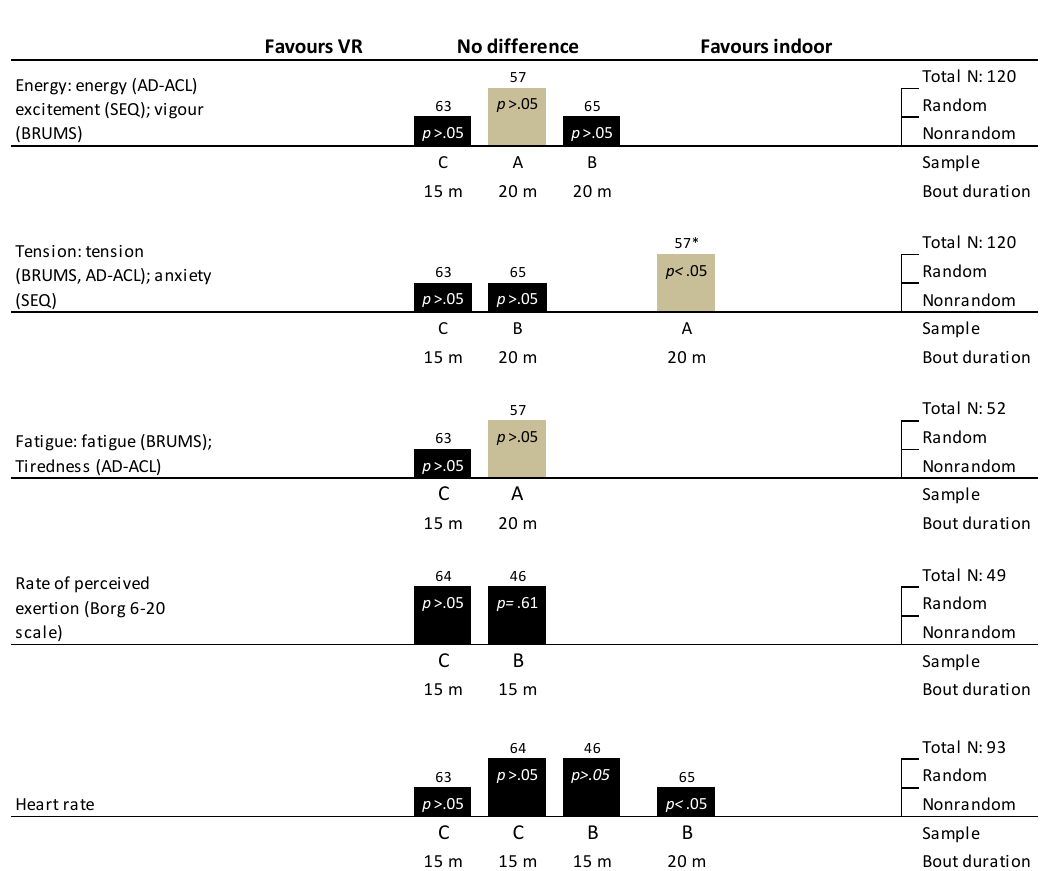
Figure 5. Harvest plots of trials investigating outdoor green exercise versus virtual green exercise. Note: A: studies with ≥ 40 participants; B: studies with 20–39 patients; C: studies with < 19 patients. We also provide the total sample across trials for each comparison (note: Plante et al. 2003 [57] did not provide group sample sizes, so we divided the total sample by the number of conditions to approximate group sizes). The taller bars represent randomized trials in this comparison, and shorter bars represent non-randomized trials. Grey bars indicate parallel group design trials, whereas black bars represent crossover design trials. p -values and effect sizes (i.e., Cohen’s d) are provided inside each bar where this information is available. Exercise bout duration is provided in minutes. The number on top of each bar represents the study: 46 = White 2015 [46]; 57 = Plante 2003 [57]; 63 = Duncan 2014 [63]; 64 = Rogerson 2015 [64]; 65 = Yeh 2017 [65]. Acronyms: VR: virtual reality; AD-ACL: Activation–Deactivation Adjective Check List; BRUMS: Brunel Mood Scale; SEQ: Sport Emotion Questionnaire. * Female participants